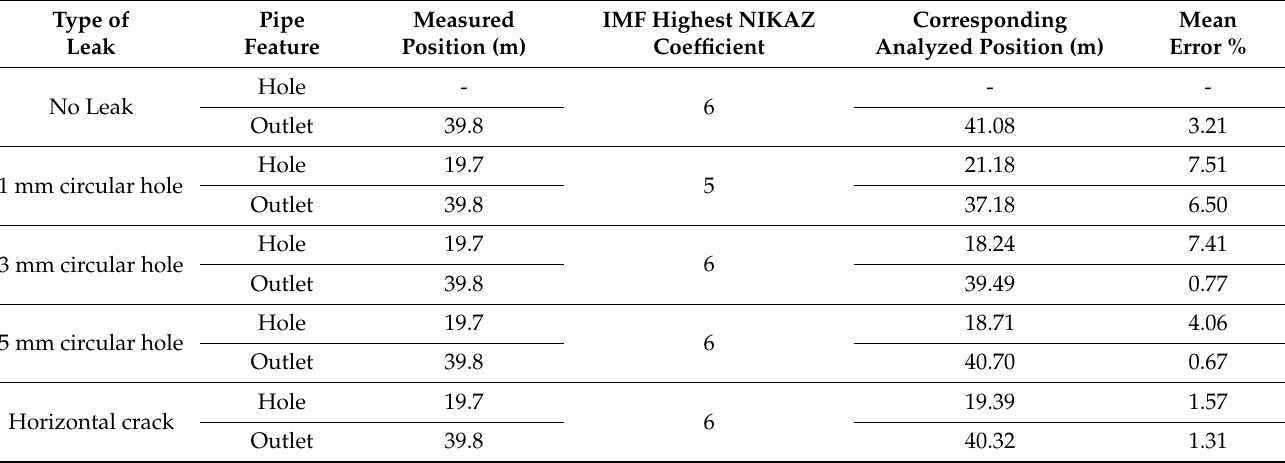
Table 3. NIKAZ evaluation for 4 bar pressurised